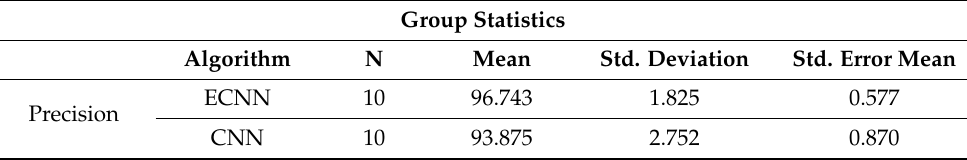
Table 6. Group statistics parameter comparison with precision for ECNN and CNN